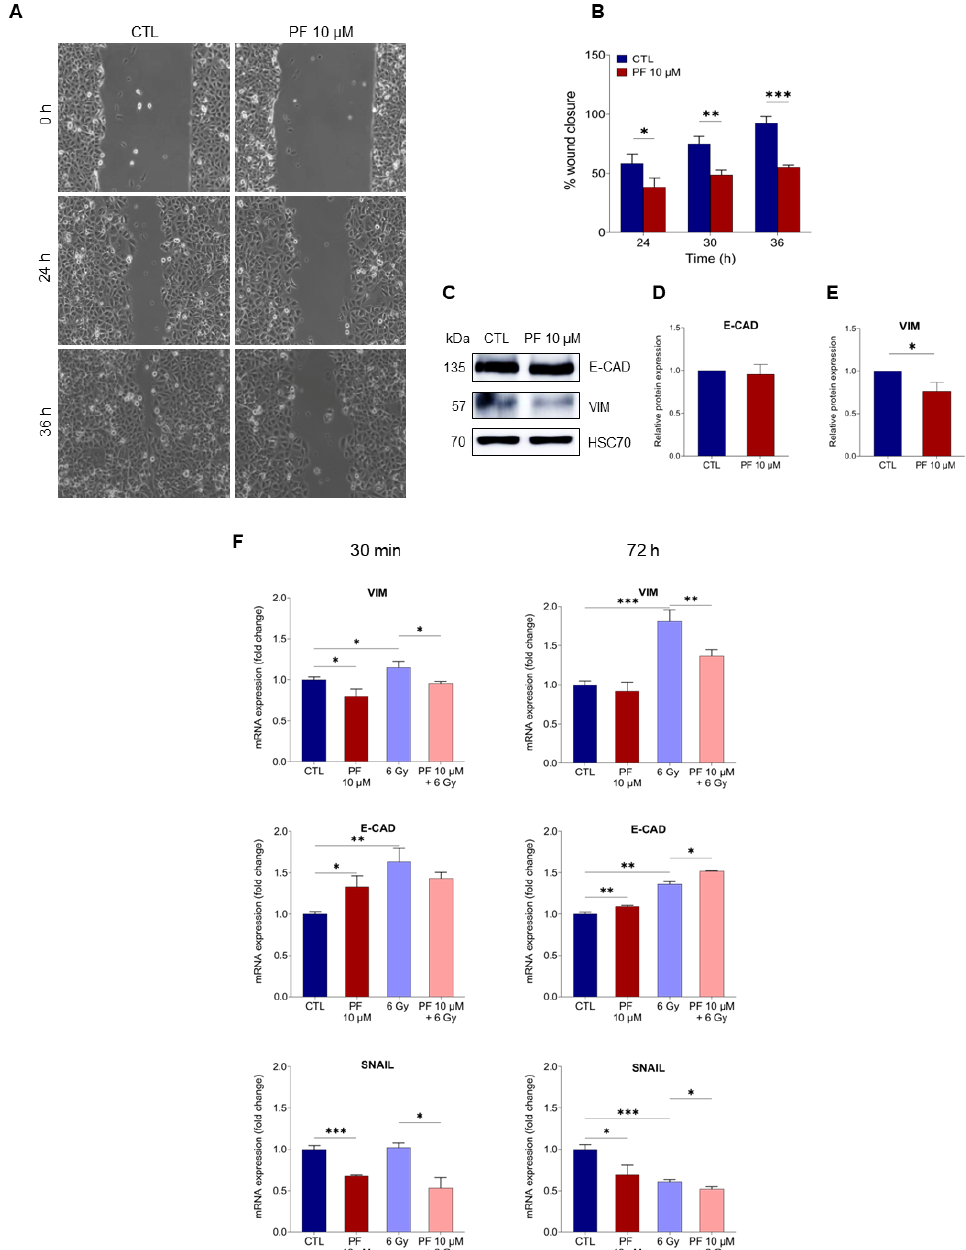
Figure 4. PF-06424439 pre-treatment reduces epithelial to mesenchymal transition on MCF7 cells. ( A ) Migration assay was performed to determine the effects of PF-06424439 on the MCF7 invasive capacity within 36 h from the scratch. ( B ) Migration was significantly decreased in cells pre-treated with PF-06424439; the bar plots show the percentage of wound closure rate from 24 to 36 h, quantified by ImageJ Fiji software. ( C ) Western blotting analysis of Vimentin and E-cadherin protein expression in MCF7 cells analyzed after 72 h of treated 10 µM PF-06424439 treatment. ( D , E ) Protein levels were quantified by ImageJ software and the results were normalized to the control. HSC70 was used as a loading control. ( F ) RT q-PCR for EMT markers (E-cadherin, Vimentin, and Snail) of MCF7 cells untreated or pre-treated with PF-06424439 and exposed to 6 Gy, 30 min and 72 h after irradiation. Data were collected from three independent experiments and are shown as means ± SD (* p ≤ 0.05; ** p ≤ 0.01; *** p ≤ 0.001).